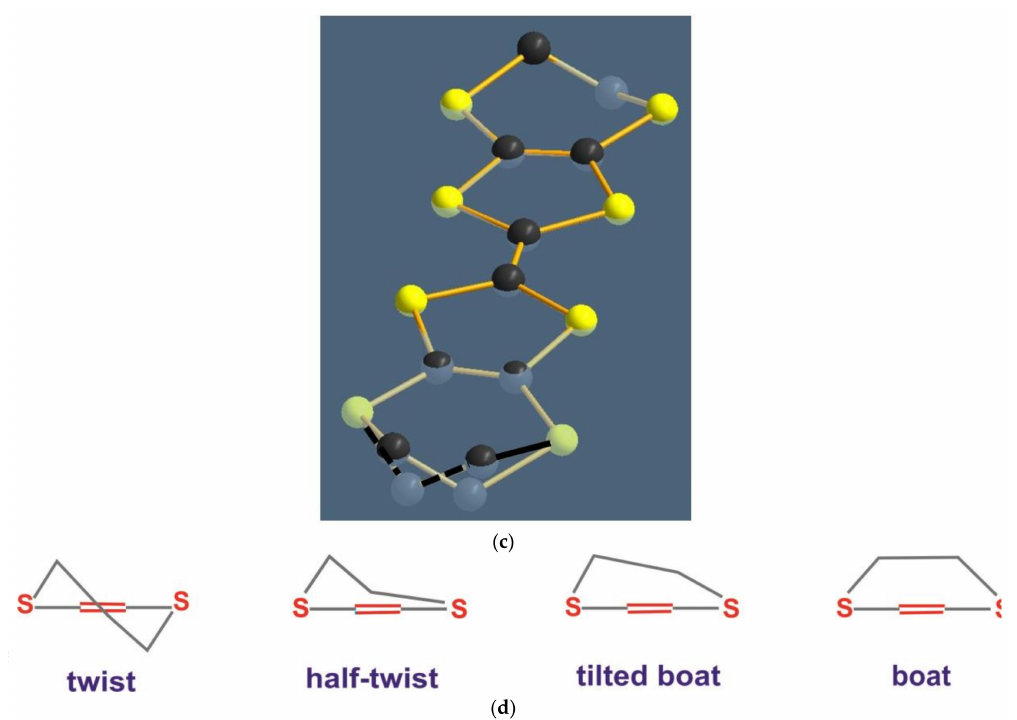
Figure 2. (Color online). ( a ) Ellipsoid of the ADPs at 300 K and labels for the various C and S atoms of the BEDT-TTF molecule i (i = 1 for Molecule 1 and i = 2 for Molecule 2). The two ethylene groups on the left side are in the t and t twist configurations (t and t are twist conformations symmetrically related with respect to the plane of the molecule). The ethylene group, which is not split, is also presented and is in the twist configuration. Schematic view of the terminal ethylene groups of the BEDT-TTF molecule in the ( b ) staggered (S: t, t) and ( c ) eclipsed (E: t, t ) conformations. The blue plane is the average molecular plane. Dashed lines represent part of the chemical bond below the average molecular plane; ( d ) Schematic representation of the four possible conformations of an ethylene group in the BEDT-TTF molecule (each ethylene group is represented by two C atoms and viewed along the long axis of the molecule). The energy of the conformation increases from left to right. Note that, in the twist conformation, there is a C atom on each side of the molecular plane and that, in the half-twist conformation, one C atom is in (or very near) the molecular plane. In the more energetic tilted-boat and boat conformations, the C atoms are on the same side of the molecular